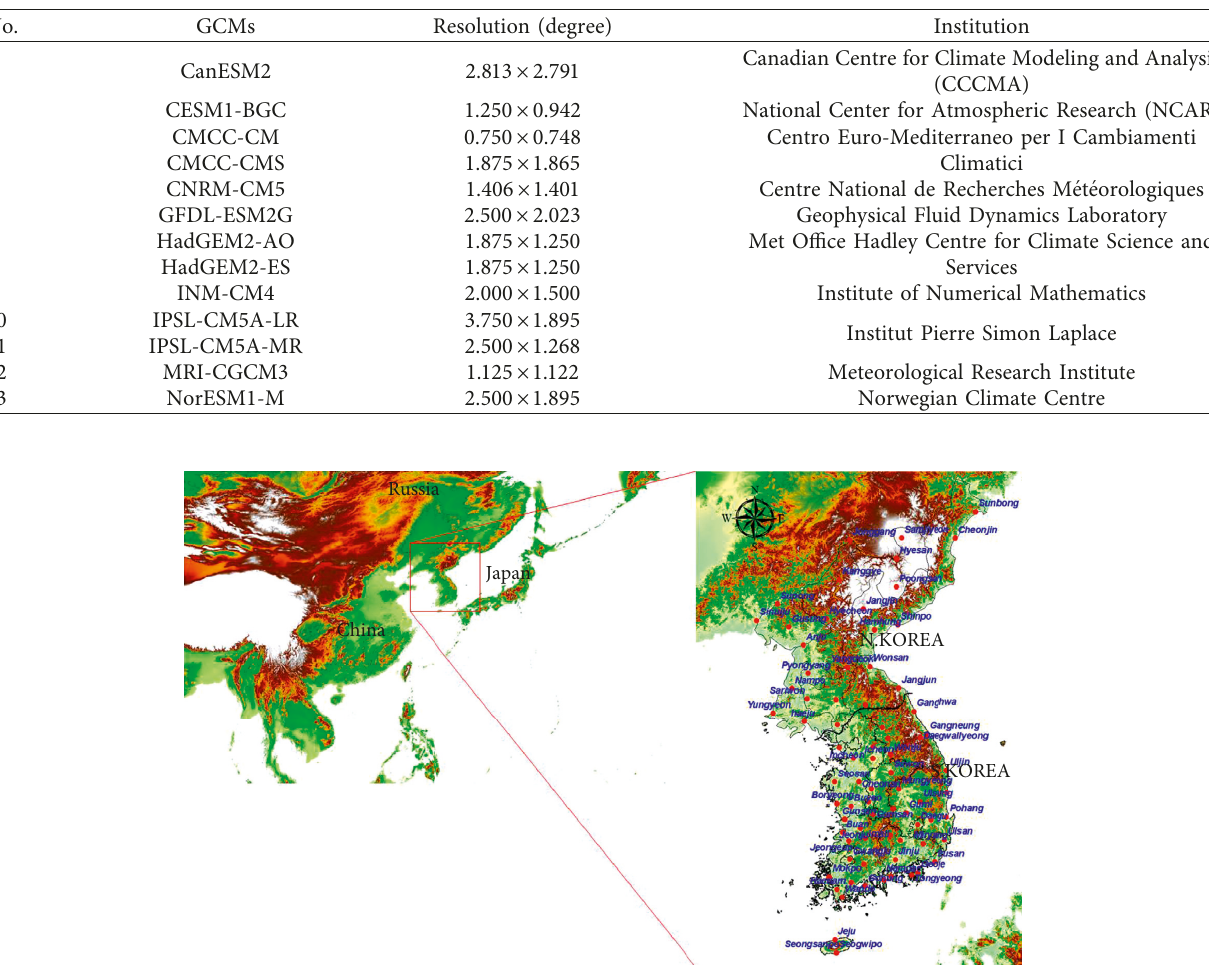
Table 2: Thirteen GCMs used for the study.